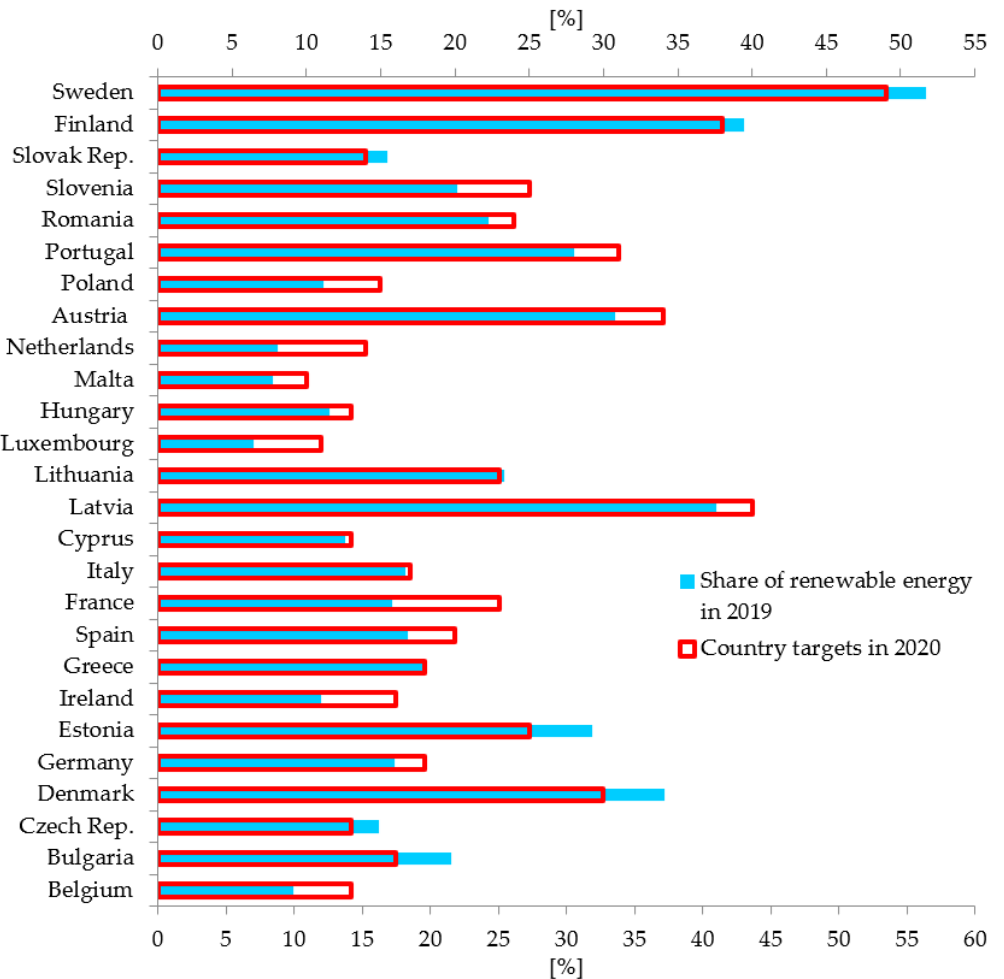
Figure 2. Share of renewable energy sources in European Union and targets for 2020. Adapted from Ref. [4].